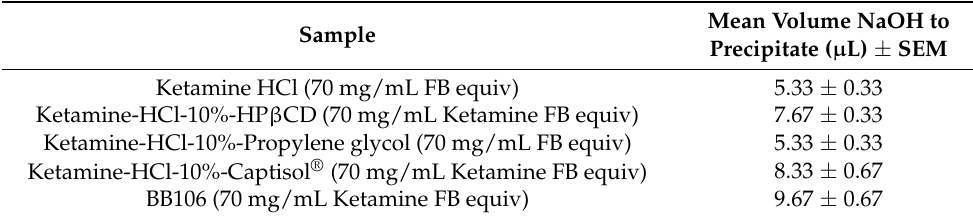
Table 3. Forced precipitation of Ketamine with 2M NaOH after pH 5.5, starting pHs 5.50 ± 0.01. Experiments performed on a 2 mL volume. NaOH added in 1 µ L volumes. Data presented as mean ± SEM. N =